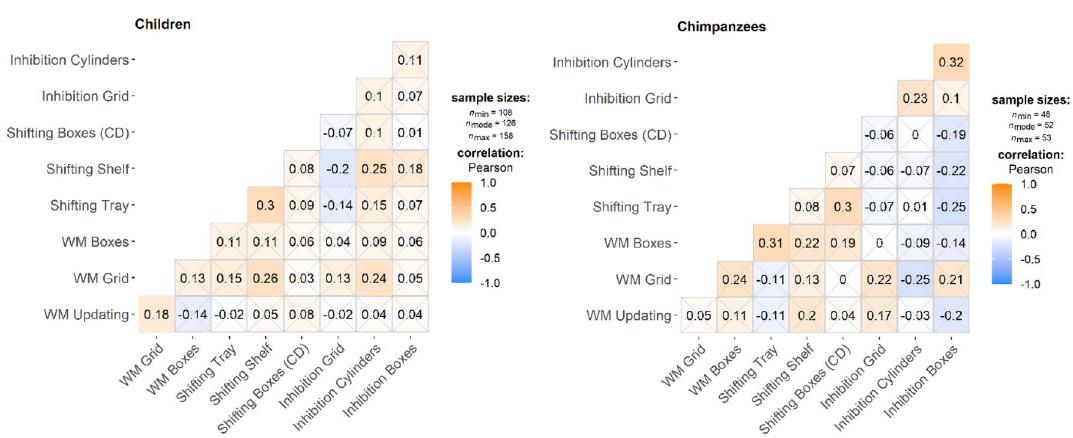
Figure 2. Pearson correlations across all nine tasks for the child sample (left, n = 185) and the chimpanzee sample (right, N = 55; variables centered by site) using pairwise complete observations. Non-significant correlations ( p > 0.05) are crossed out. Positive correlation parameters are depicted in orange, negative values in